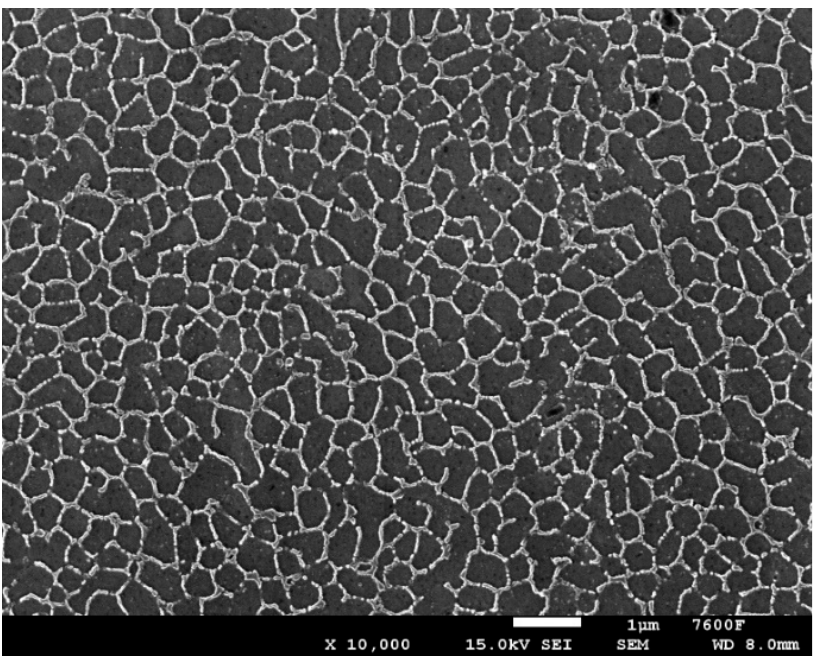
Figure 4. SEM analysis of the microstructure of as-built L-PBF AlSi10Mg sample in the transverse cross-section.